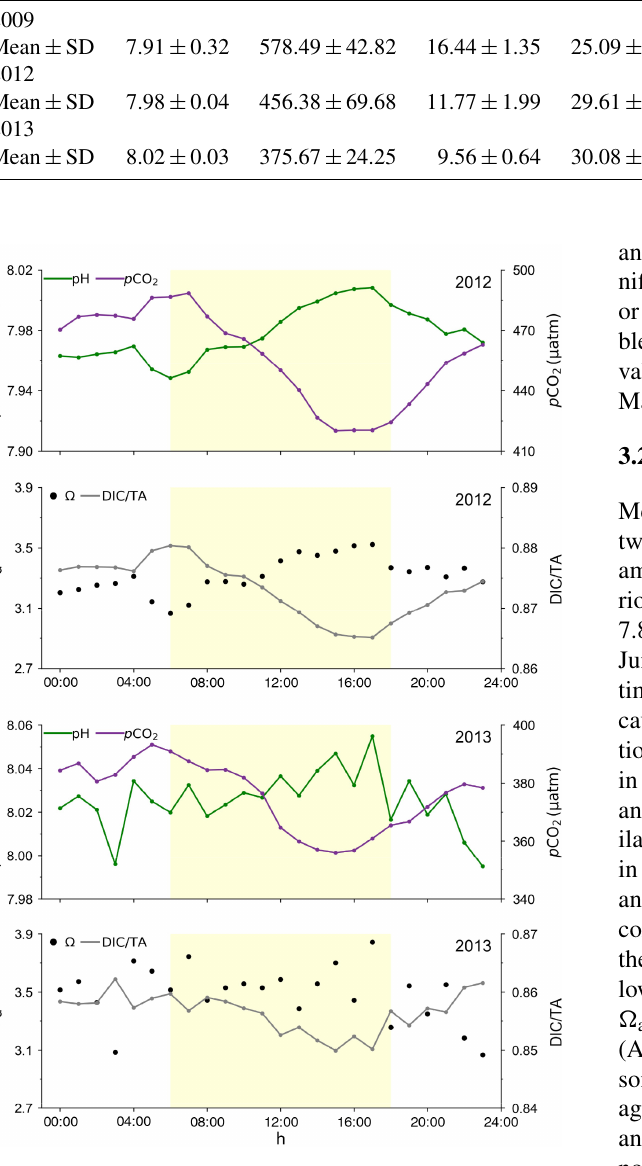
Figure 4. Diel pattern of parameters measured in Bahía Culebra. Data points are hourly averages of 15 and 7 consecutive days in 2012 (a, b) and 2013 (c, d) , respectively. The shaded area represents daylight